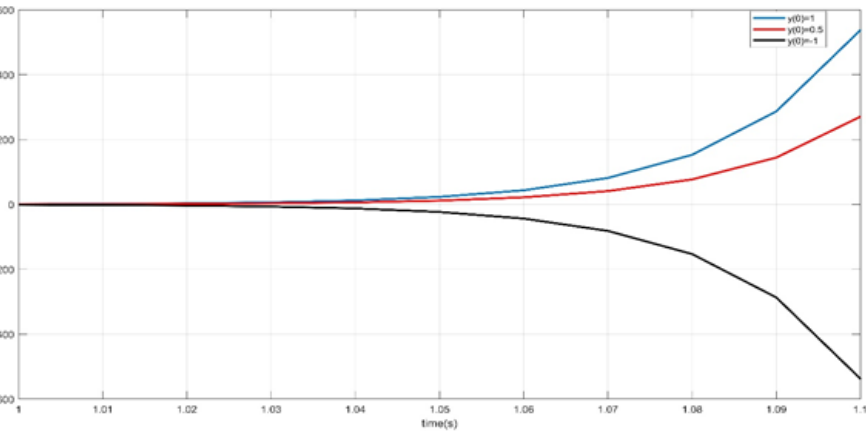
Figure 3. The paths of y ( t ) solutions of continuous and discrete scalar IDDE (15), which are unstable for different initial values, y ( 0 ) = − 1, y ( 0 ) = 0.5 and y ( 0 ) = 1. 5.